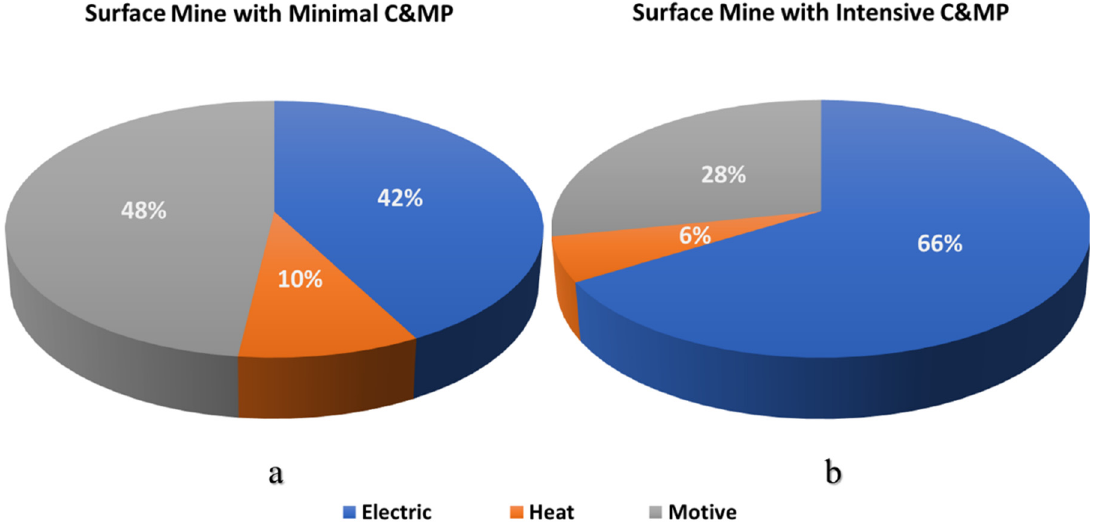
Figure 1. Energy profile of a typical open-pit mining operations: ( a ) Open-pit mine with minimal C&MP; ( b ) open-pit mine with intensive C&MP [17].